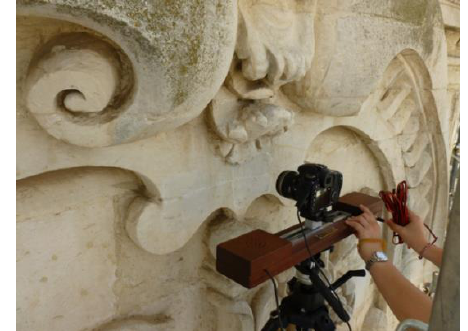
Figure 5. Measurement set-up of UCRP on the façade of the Lecce’s Cathedral